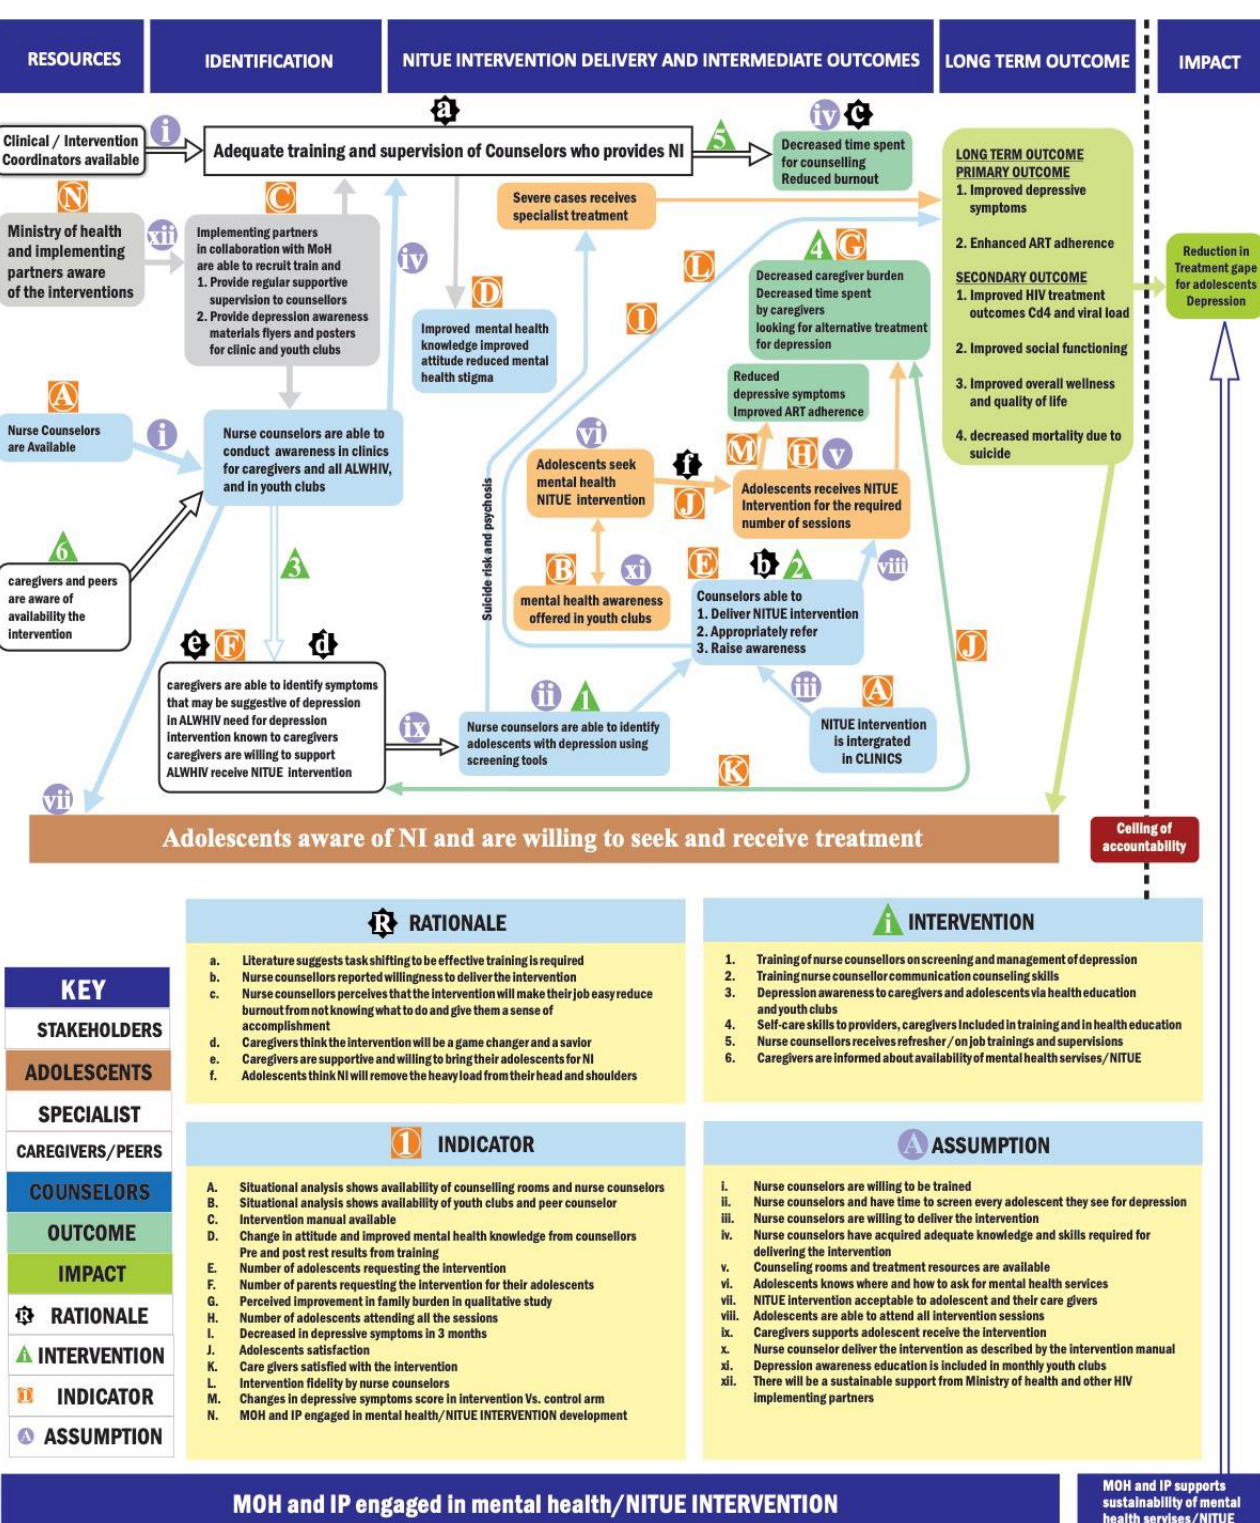
Figure 1. Theory of Change Map for the NITUE Intervention